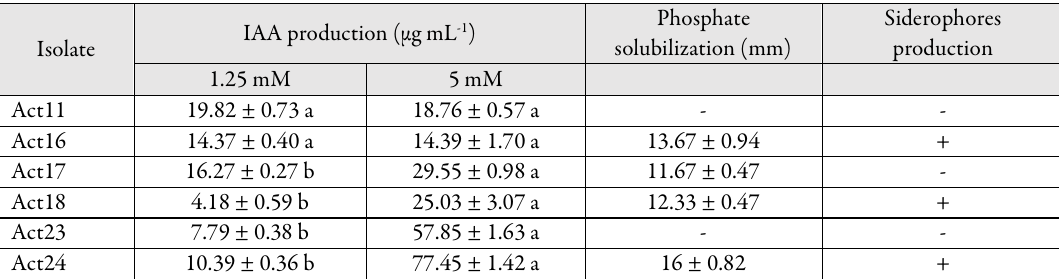
Phosphate solubilization (mm)